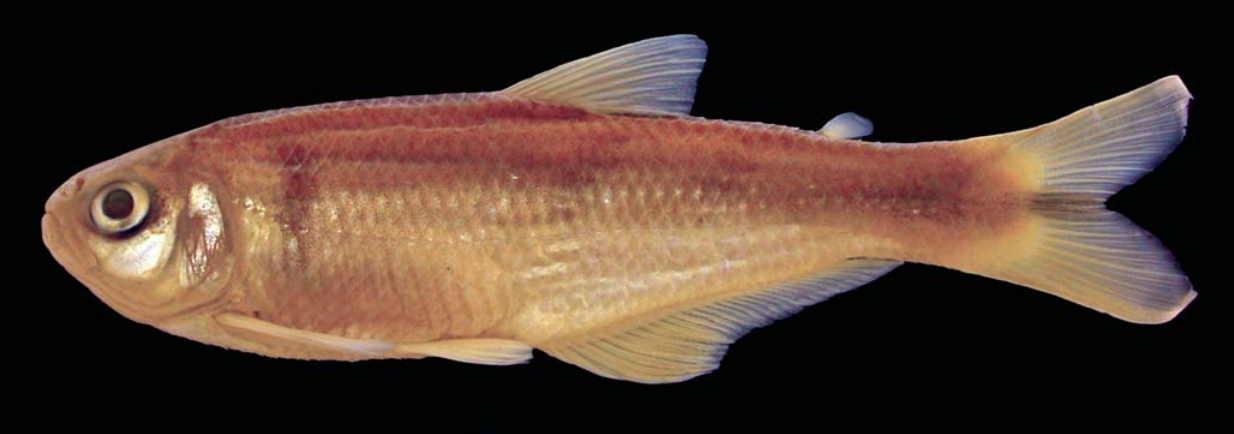
Fig. 19. Hemibrycon polyodon , KU 20004, male, 71.2 mm SL, río Pastaza basin, Ecuador.